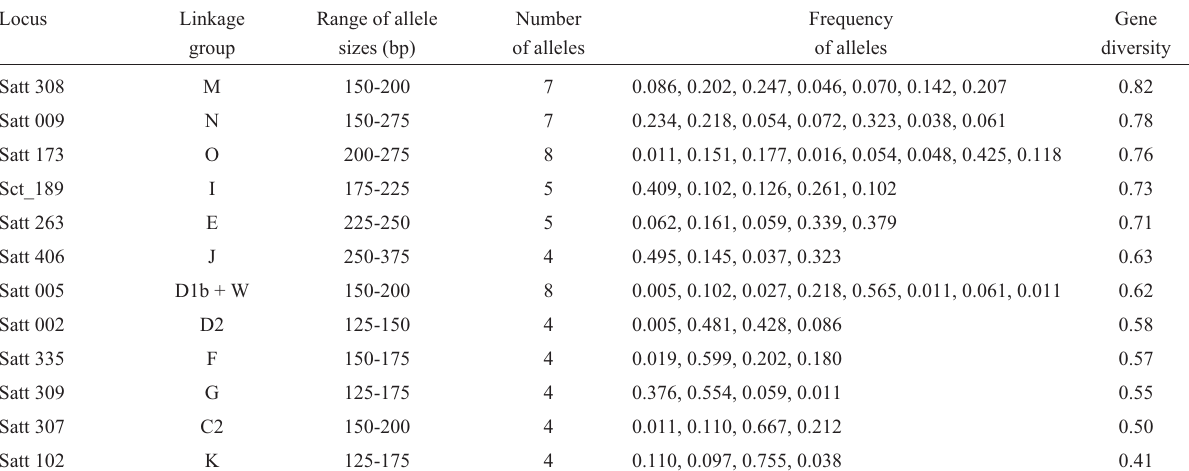
Table II - Linkage group, allele size range, number, frequency, and gene diversity of 12 SSR loci in 186 soybean cultivars. Locus